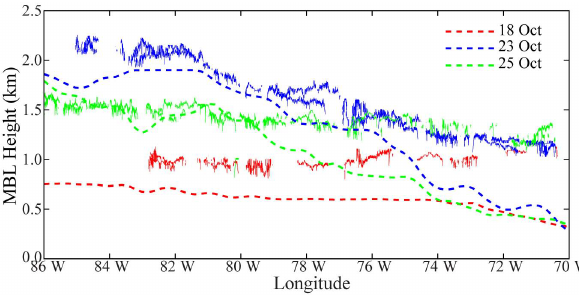
Fig. 3. Examples of the MBL depth along 20 ◦ S from the WRF (dashed) and detected by the Wyoming Cloud Radar (solid) for 18 October (red), 23 October (blue), and 25 October